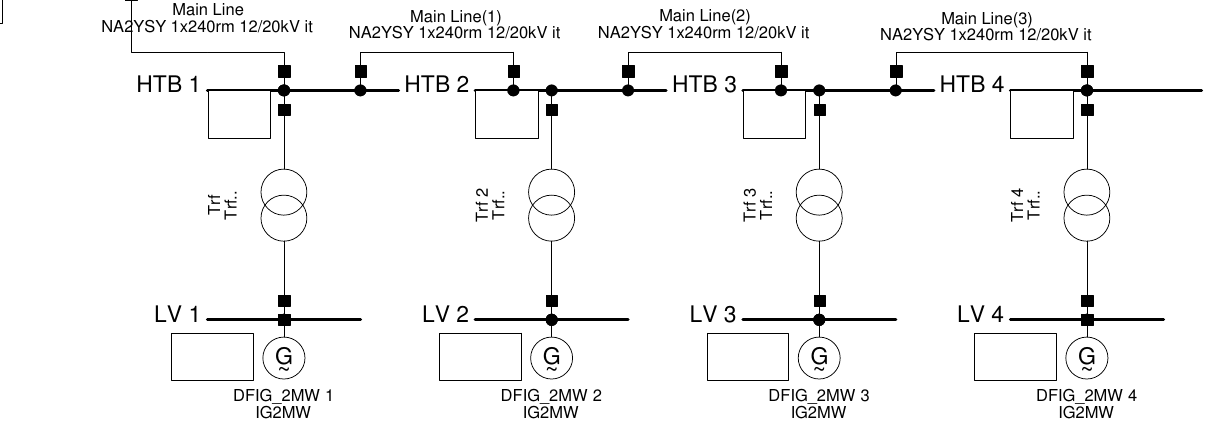
Figure 5. Wind generation system modeled via